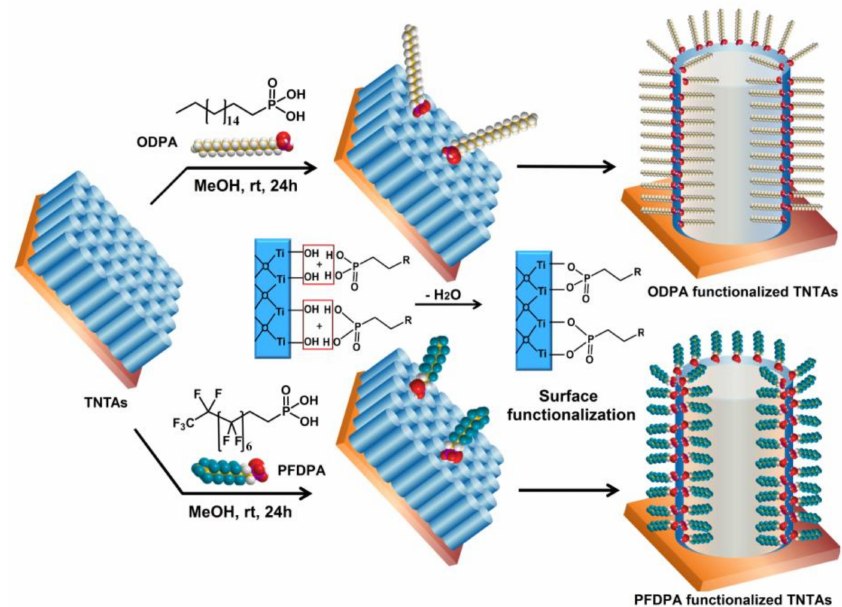
Figure 2. Schematic illustration of the TiO 2 nanotube arrays (TNTAs) and the conformal surface functionalization of TNTAs with octadecylphosphonic acid (ODPA) or 1H, 1H (cid:48) , 2H, 2H (cid:48) -perfluorodecyl phosphonic acid (PFDPA) molecules to form superhydrophobic TNTAs.